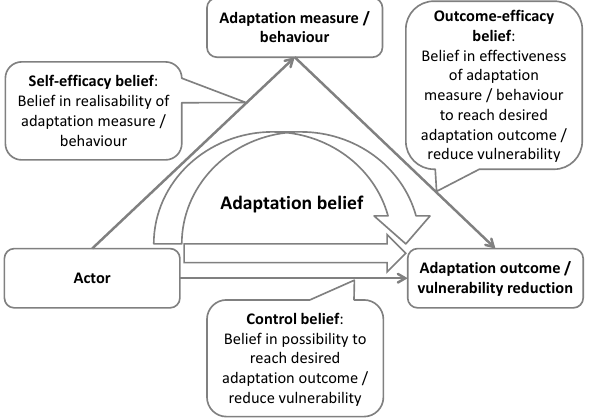
Fig. 2. Illustration of the adaptation belief concept and ways to assess it (developed from Hoff and Walter, 1996).